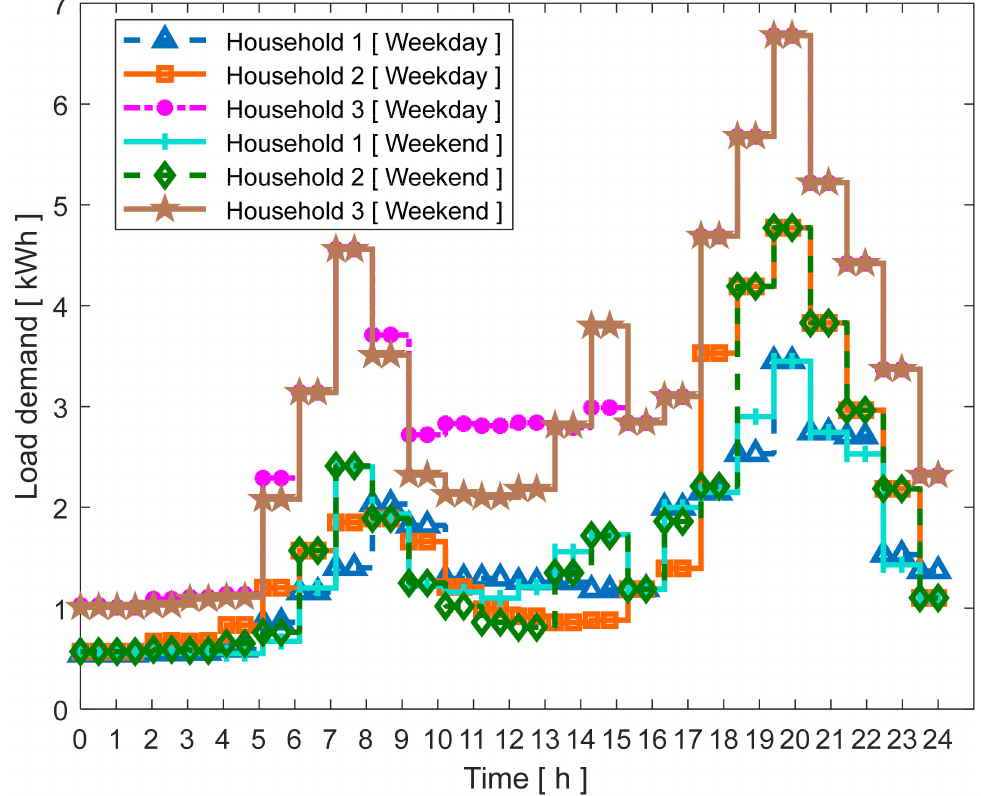
Figure 8. Daily household electricity consumption variation curve for three different households’ daily load profiles during weekdays and weekends in Pretoria. Corresponding color names: blue, orange, purple, teal, green, magenta,